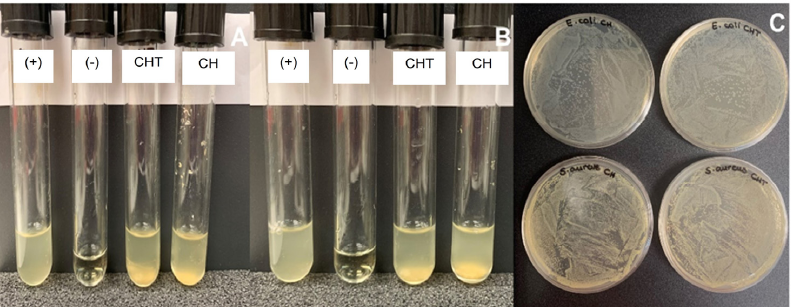
Figure 5. Antimicrobial activity assay of chitin (CH) and chitosan (CHT) powder from S. entomon against E. coli ( A ) and S. aureus ( B ). Growth on plates ( C ). Table 2. Antimicrobial activity of chitin and chitosan, from different sources, in powder